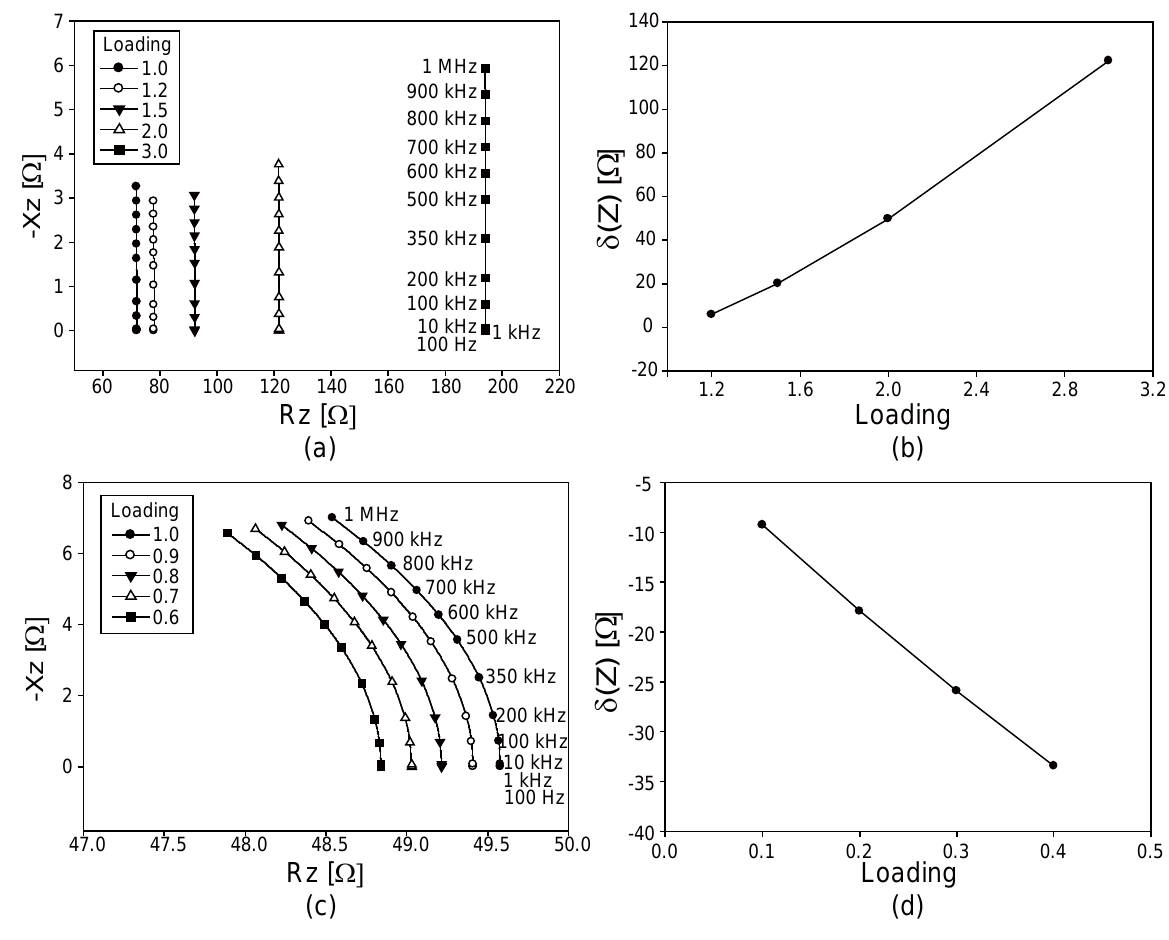
Figure 6. Simulation results of impedance spectra of conductive fabrics under tension and compression. ( a ) and ( c ) are the Argand diagrams. ( b ) and ( d ) show changes in the magnitude of the impedance for different amounts of